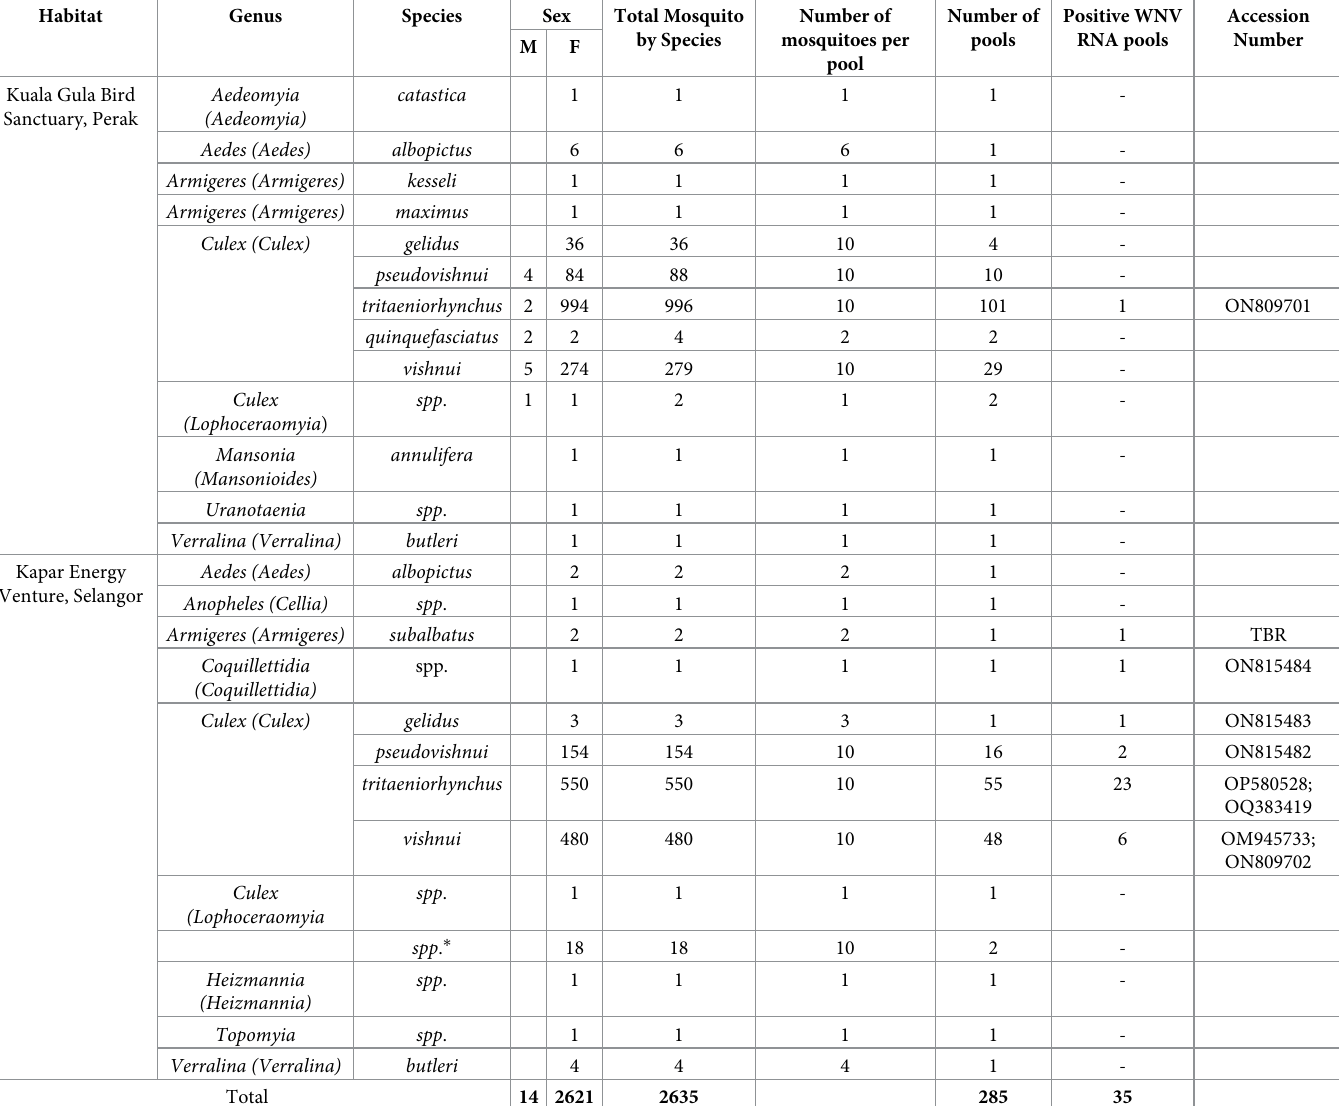
Table 2. Mosquito Distribution According to Location, Genus, Species, Sex and Pool Number.